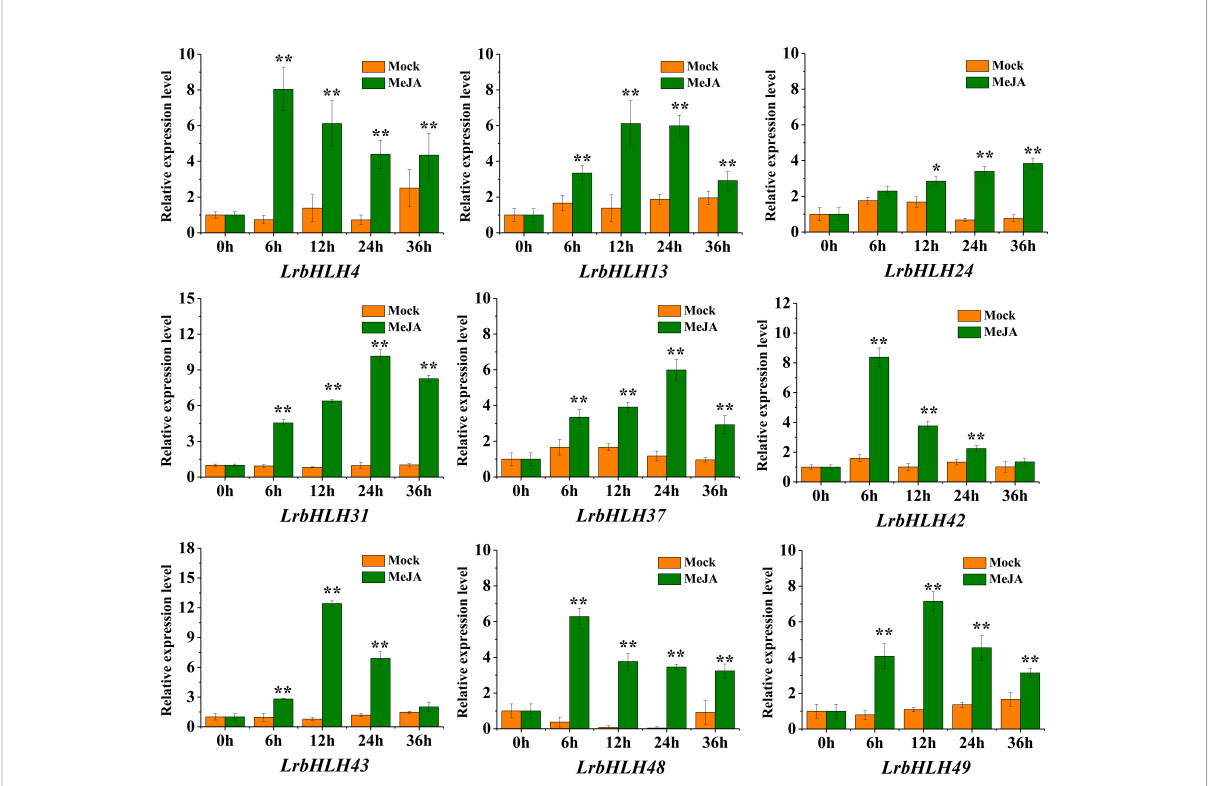
FIGURE 7 qRT-PCR analysis of LrbHLHs under MeJA treatment. The values represent means ± SD (n = 3). * and ** indicates signi fi cant difference between control and treatment according to student ’ s t-test at p < 0.05 and p < 0.01 level,